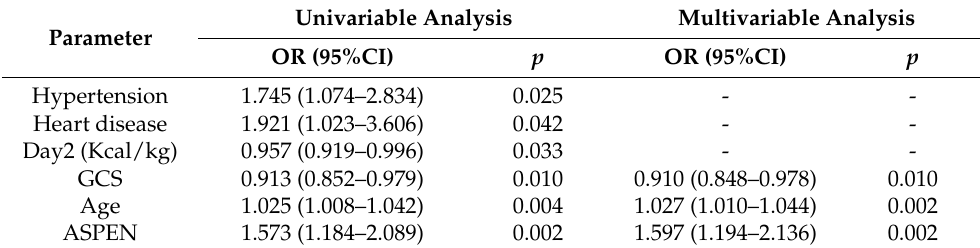
Table 3. Logistic regression analysis to identify predictors of RFS (Model A).